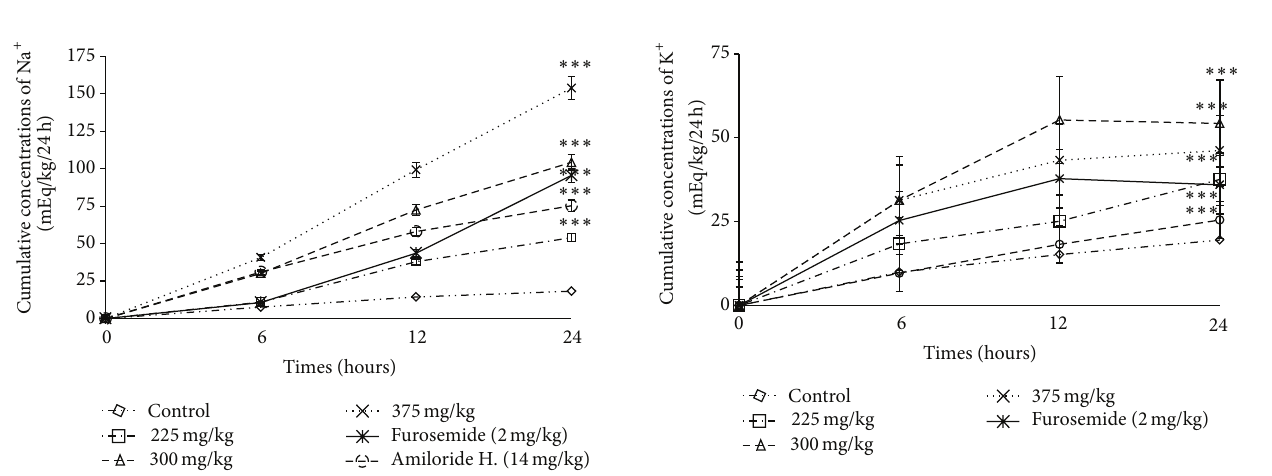
Figure 6: Effects of the aqueous extract of F. glumosa on the cumulative K + excretion. Values are means ± SEM, 𝑛 = 5 , ∗ ∗ ∗ < 0.001 , significant difference compared to the